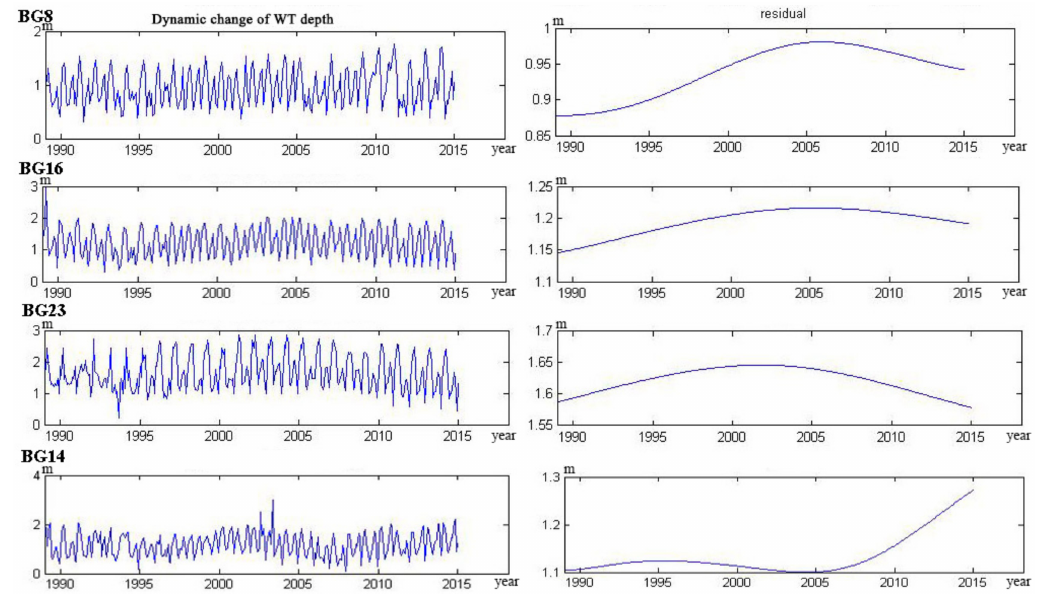
Figure 10. Empirical Modal Decomposition of the fourth and fifth types of